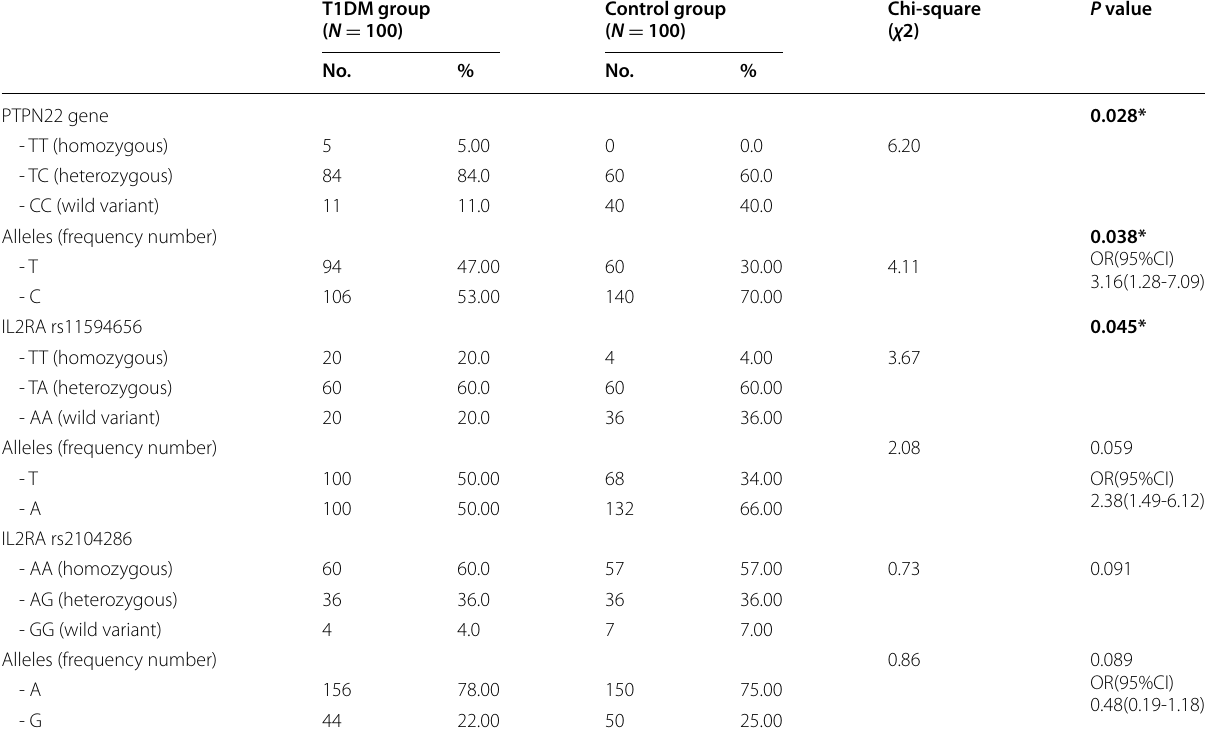
the studied patients and control